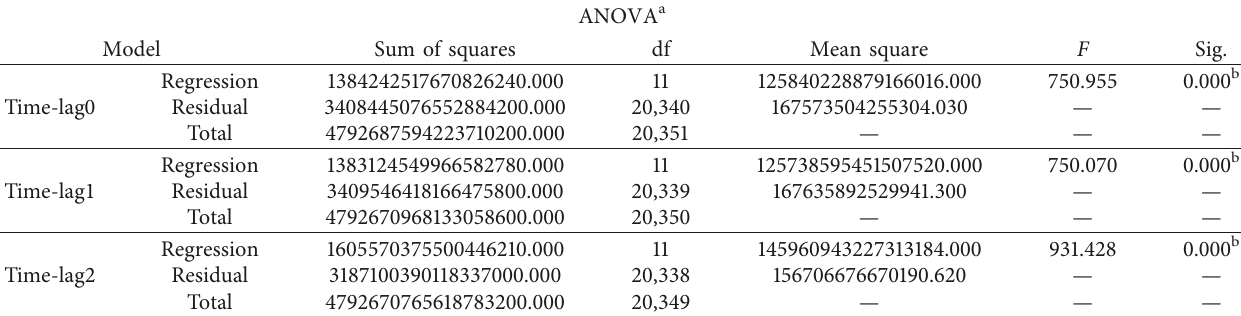
Table 11: Residual summary for a DOE medium office building depending on